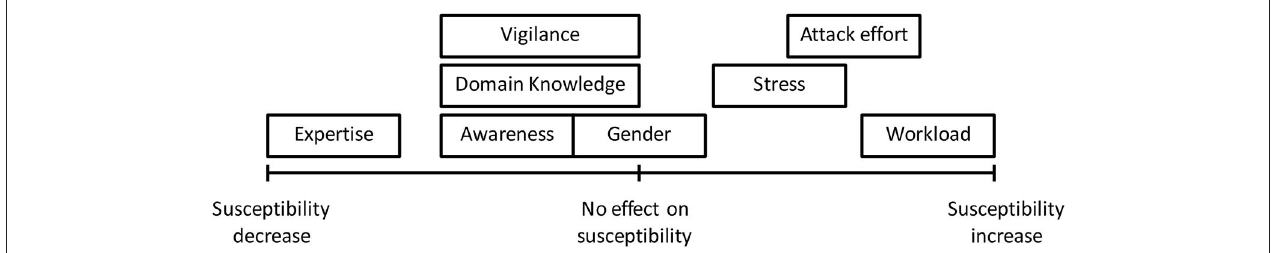
FIGURE 3 | Our speculation of the impact on one’s susceptibility to social engineering cyberattacks: a factor on the left-hand side means that substantially increasing the factor (e.g., expertise) will decrease one’s susceptibility, with further left indicating a bigger degree in decreasing susceptibility; a factor on the right-hand side means that substantially increasing the factor (e.g., workload) will increase one’s susceptibility, with further right indicating a bigger degree in increasing susceptibility; gender has little or no effect on one’s